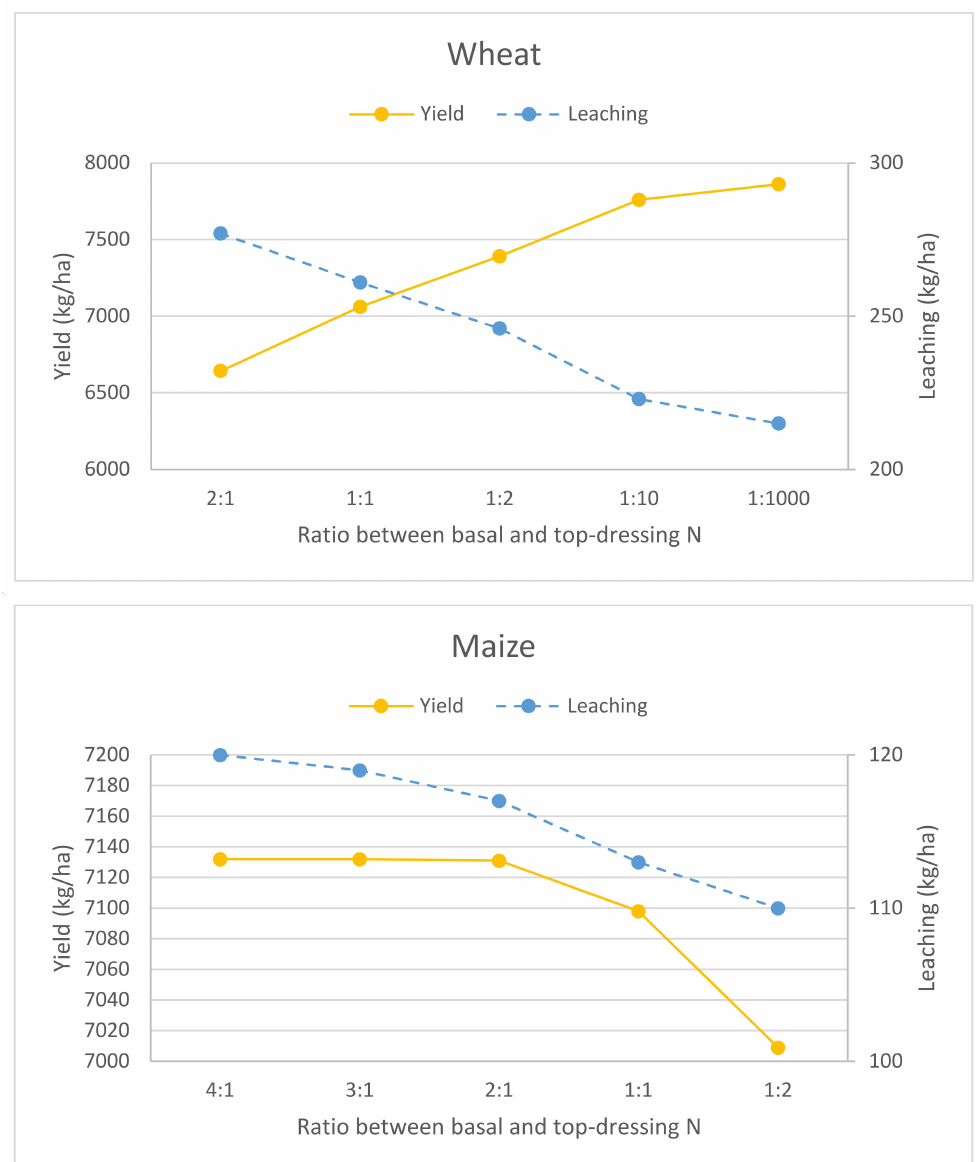
Figure 6. Yield and leaching for different basal/top-dressing N ratios for wheat and